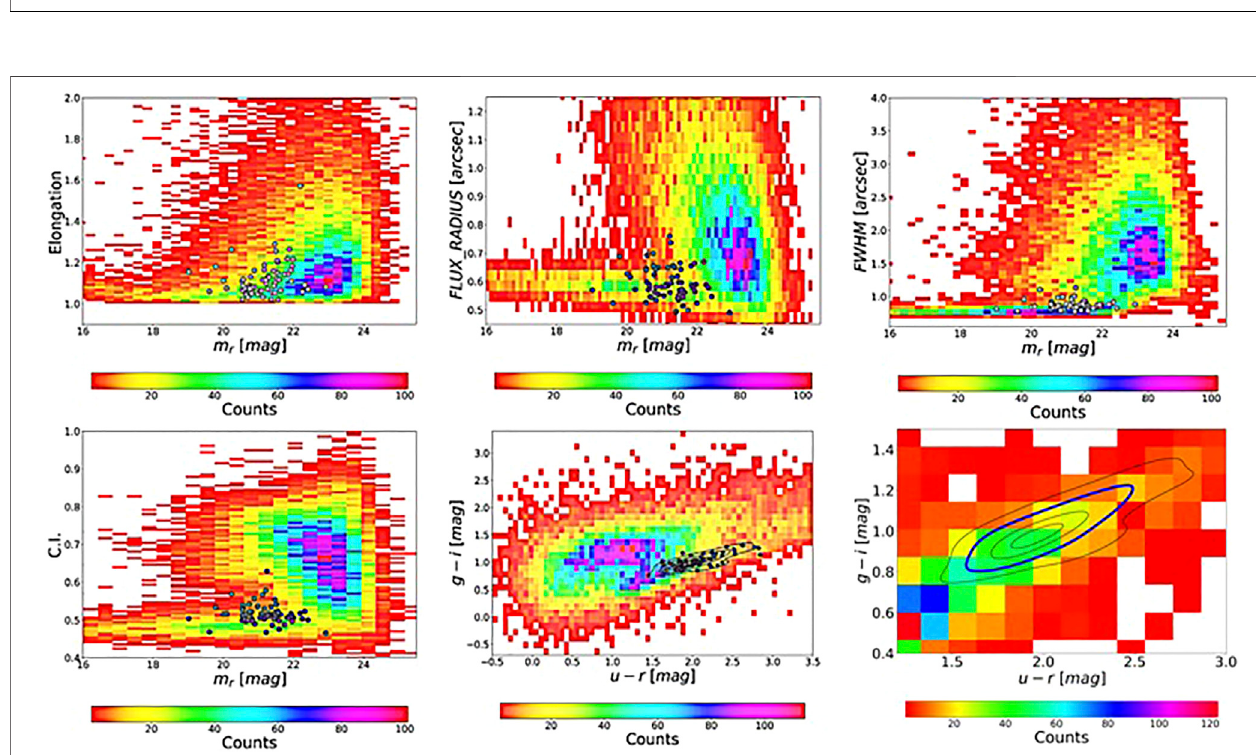
FIGURE6| Upperpanels:SExtractoroutputparametersinthe r -bandforthefullsampleofdetectedand ugri matchedsourcesvscorrected r -bandmagnitude m r . Black circles show the GCs from the master catalog. Lower panels: As upper, but concentration index (C.I, left panel) vs m r and color-color planes (middle and right panel)areshown.Inthemiddlepanel,theisodensitycontoursofGCsfromthemastercatalogsarealsoshown.Intherightpanelthecontours,andthesecondisodensity contour (in blue containing ~60 % of objects of the master catalog) used for the fi nal GCs identi fi cation, are overlaid to the 2D-color histogram.